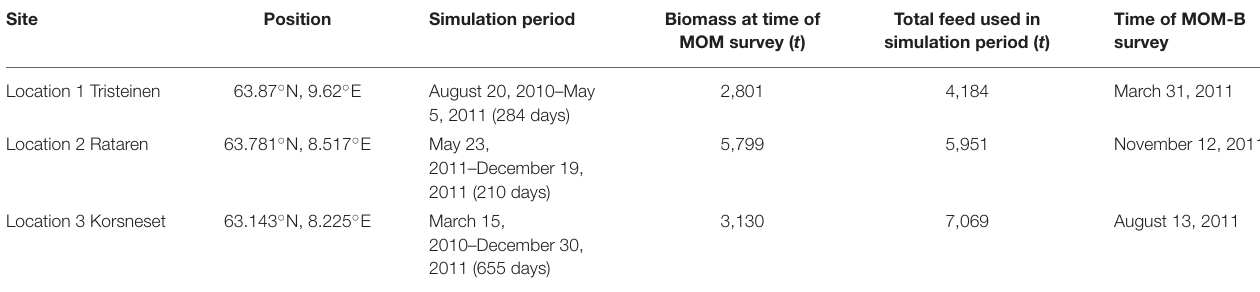
TABLE 1 | Overview of model parameters and assumptions, relevant production data, and sampling dates (MOM-B